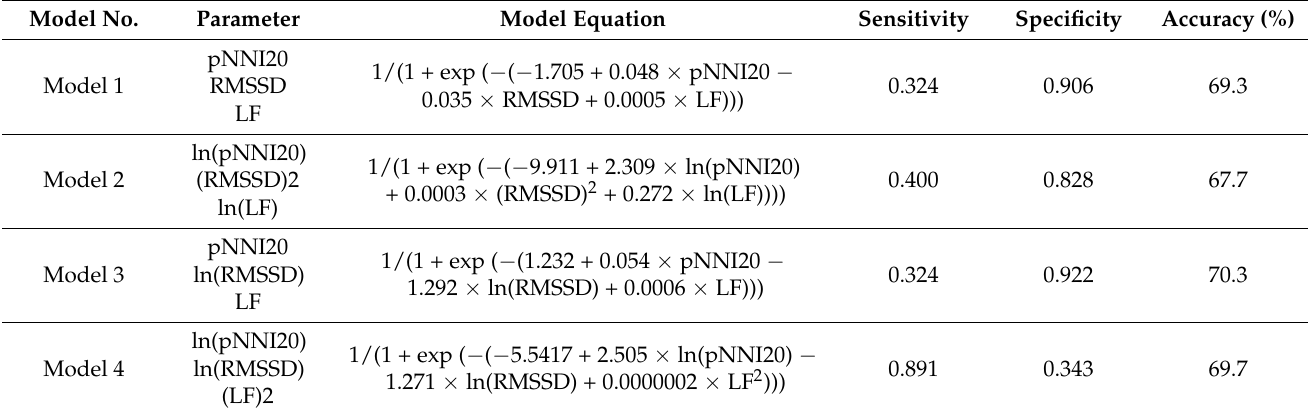
Table 7. Summary results of four logistic regression models with the highest accuracy. Model No.